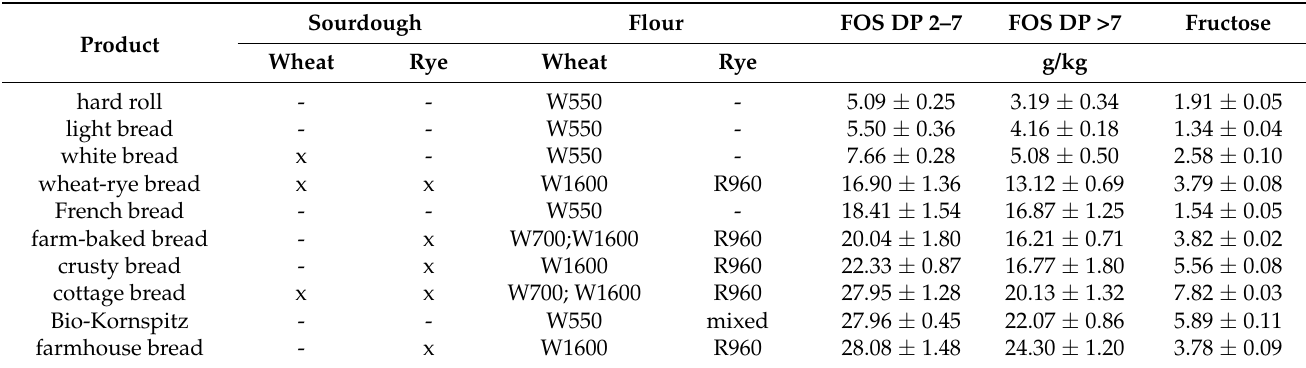
Table 2. Bakery products under study: types of sourdough used for dough proofing, flours used in production, FOS, and fructose